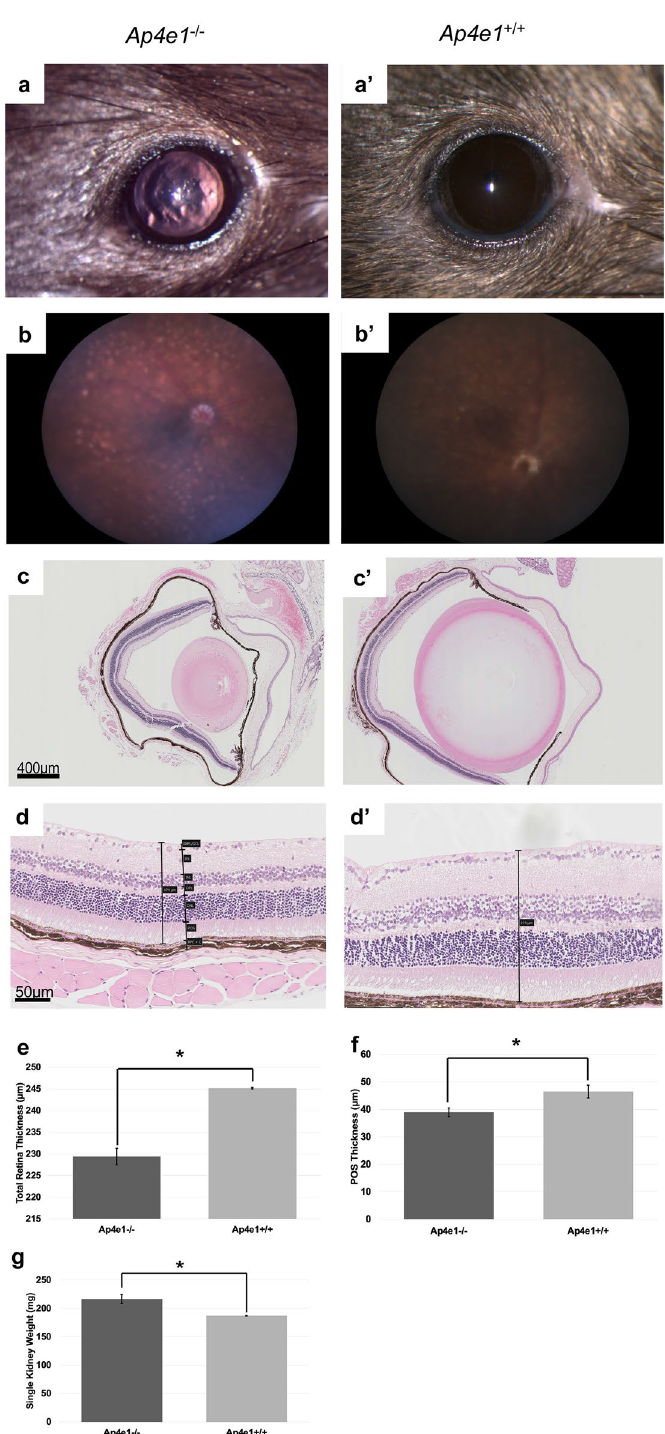
Figure 4. Ap4e1 −/− mice have ocular abnormalities in the retina, cornea, lens, and have small kidneys. ( a ) Corneal epithelial irregularity on gross examination of the eye, focally extensive corneal epithelial squamous hyperplasia. ( b ) Extensive retinal hypopigmentary lesions on color fundus photography. ( c ) Abnormal lens morphology. ( d ) Decreased total retinal thickness. Retina layers labeled where RNFL/GCL, retinal nerve fiber layer/ganglion cell layer; IPL, inner plexiform layer; INL, inner nuclear layer; OPL, outer plexiform layer; ONL, outer nuclear layer; POS, photoreceptor outer segments; RPE, retinal pigmented epithelium; C, choroid. ( e ) Quantitative measurement of average total retina thickness, where Ap4e1 + / + n = 3861, average = 245.20 µm, SE = 0.164 and Ap4e1 −/− n = 45, average = 229.39 µm, SE = 1.89, p -value = 7.78 × 10 –11 . ( f ) Quantitative measurement of POS layer thickness. Where Ap4e1 + / + n = 8, average = 46.54 µm, SE = 2.35 and Ap4e1 −/− n = 16, average = 38.99 µm, SE = 1.58, p -value = 0.019 . ( g ) Quantitative measurement of single kidney weight where Ap4e1 + / + n = 3629, 187.18 mg, SE = 0.581 and Ap4e1 −/− n = 29, 217.54 mg, SE = 7.85, p -value = 0.00085. All error bars represent standard error of the mean, * indicates p -value < .05 result of student’s two-tailed